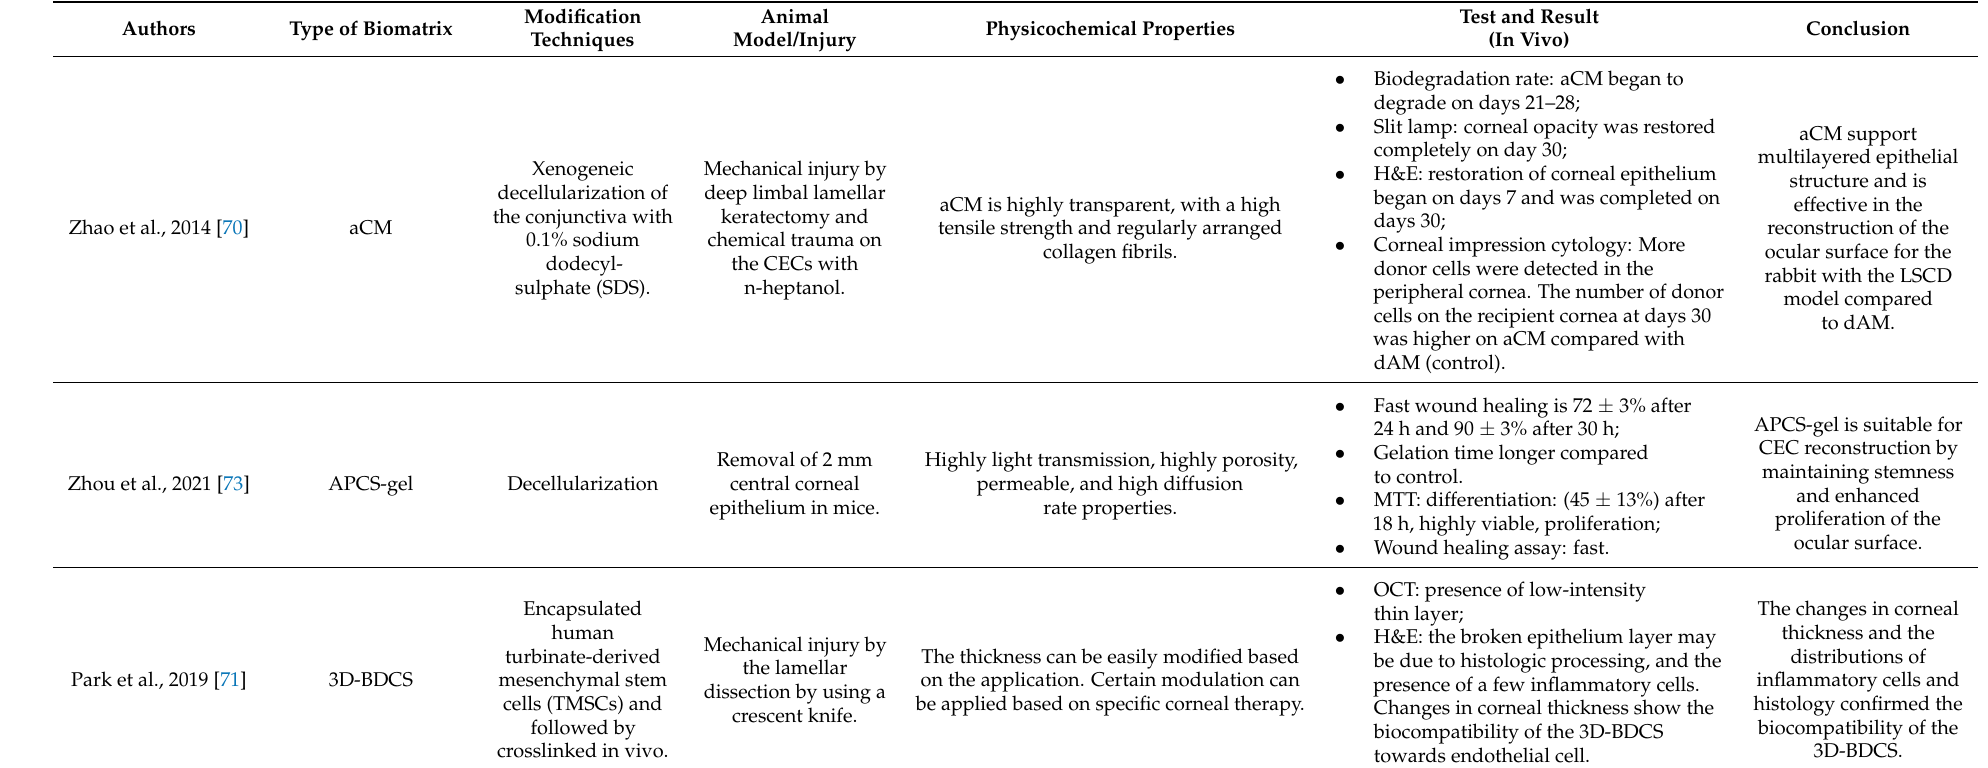
Table 2. Description of selected in vivo studies on the modified collagen